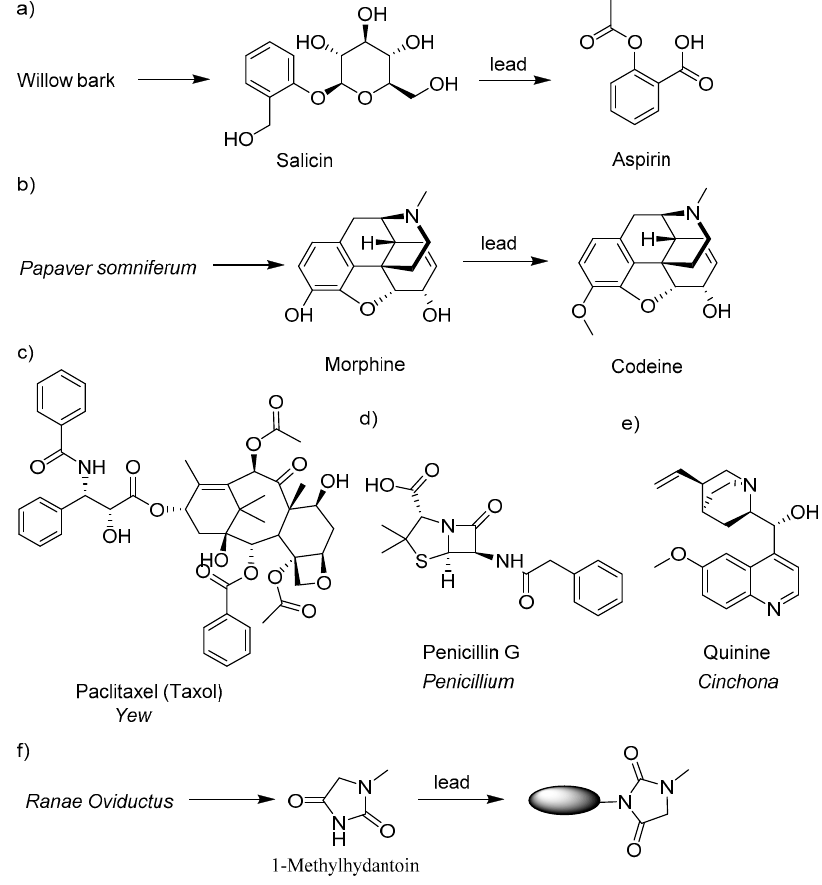
Figure 1. Examples used natural product (NP) resources in drug discovery. ( a ) Aspirin was developed from natural product salicin. ( b ) Codeine was prepared using morphine as the lead compound. ( c ) The anticancer drug paclitaxel was isolated from yew. ( d ) and ( e ) Penicillin G and quinine were isolated from Penicillium and Cinchona respectively. ( f ) The strategy of developing dual-active agents using a natural product lead compound 1 ‐ methylhydantoin.